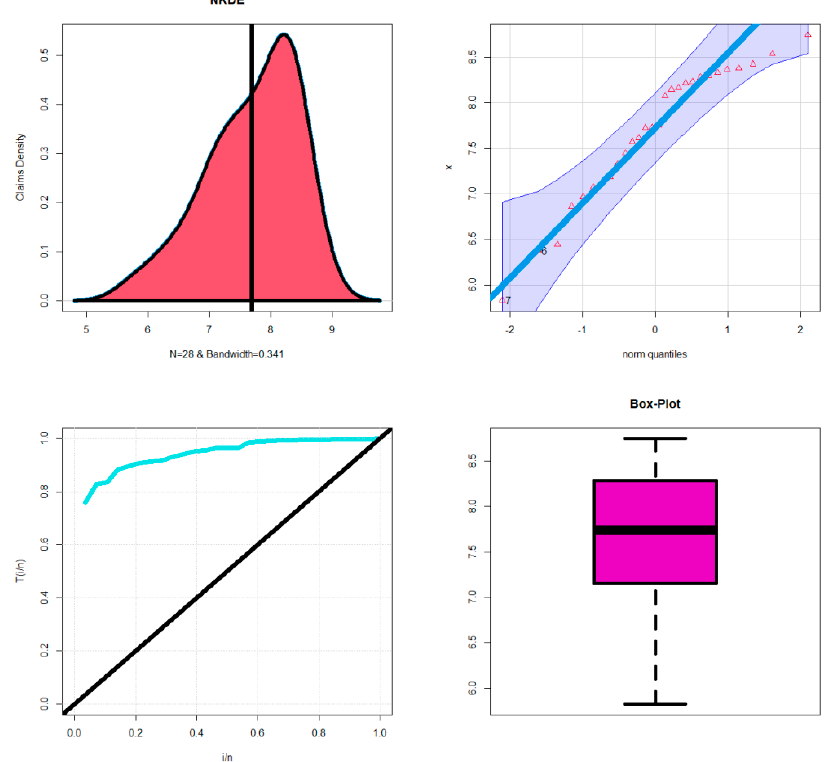
Figure 11. NKDE (top left), Q-Q (top right), TTT (bottom left), and box panels (bottom right) for the claims data.